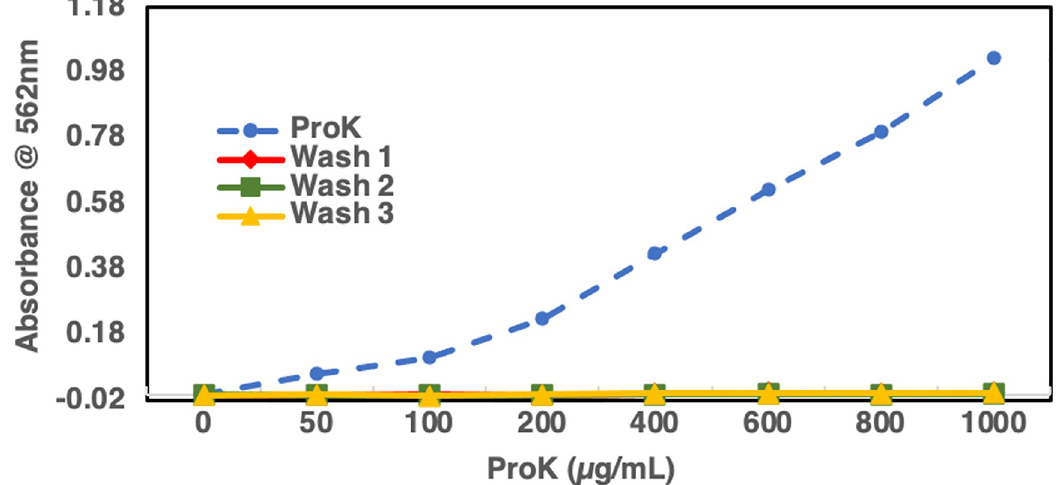
Fig 3. Graphical representation showing negligible loss of Proteinase K. During the immobilization steps where Wash 1, 2 and 3 are from the washes tested in a BCA protein estimation assay from steps following the immobilization of Proteinase K to the filter paper, treatment with NaBH 3 CN to preserve the covalent bonding and the final wash before the blocking of the non specific sites respectively. The blue dotted line shows the Proteinase K stock solution used for immobilization.